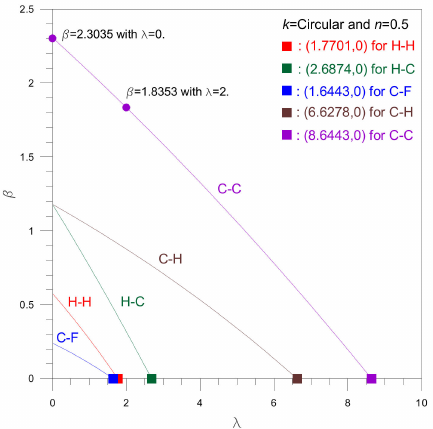
Figure 4. Chart of conjugate eigenvalues of ( β , λ )